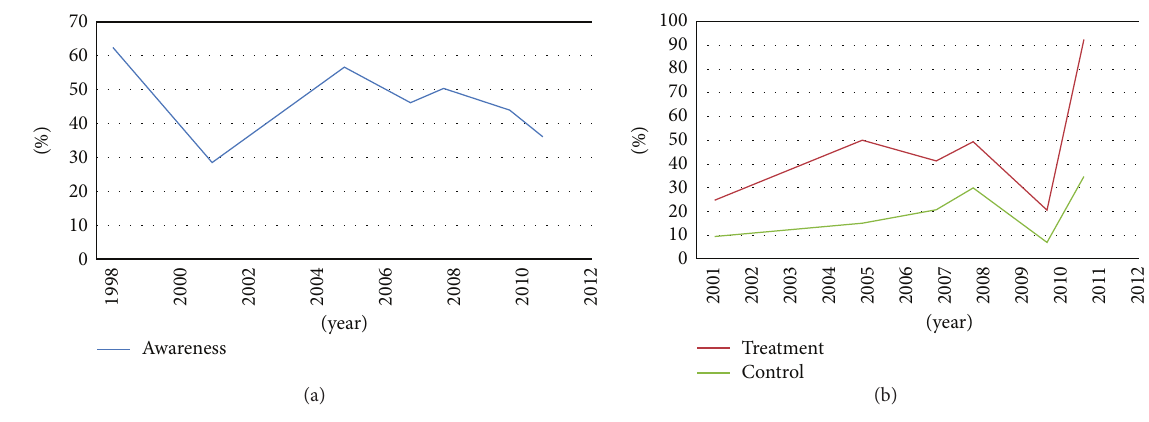
Figure 2: Trends in awareness, treatment, and control of